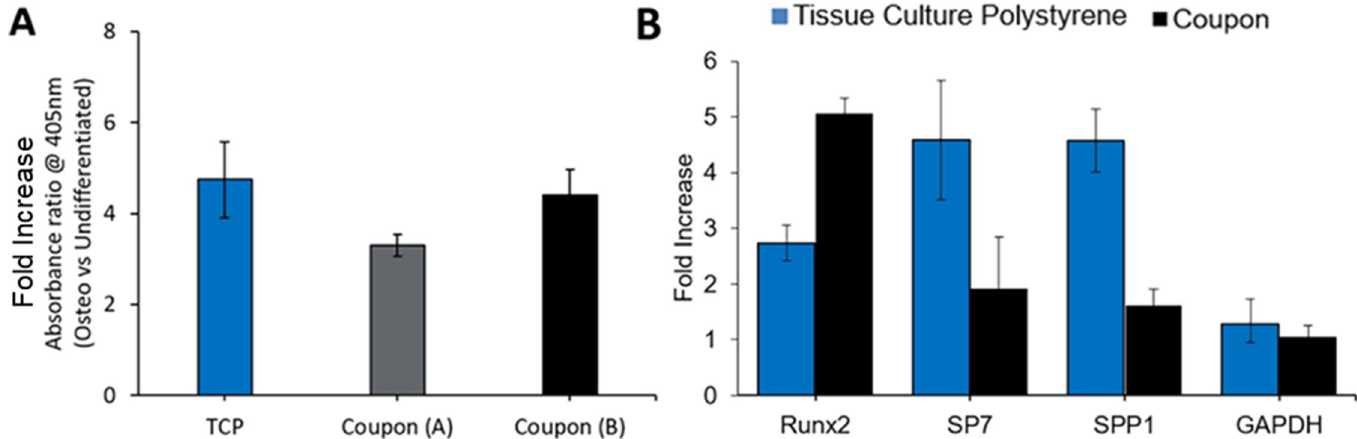
Fig 7. Expression of alkaline phosphatase and RT-PCR analysis for MSCs differentiated on DLP printed HA coupons.